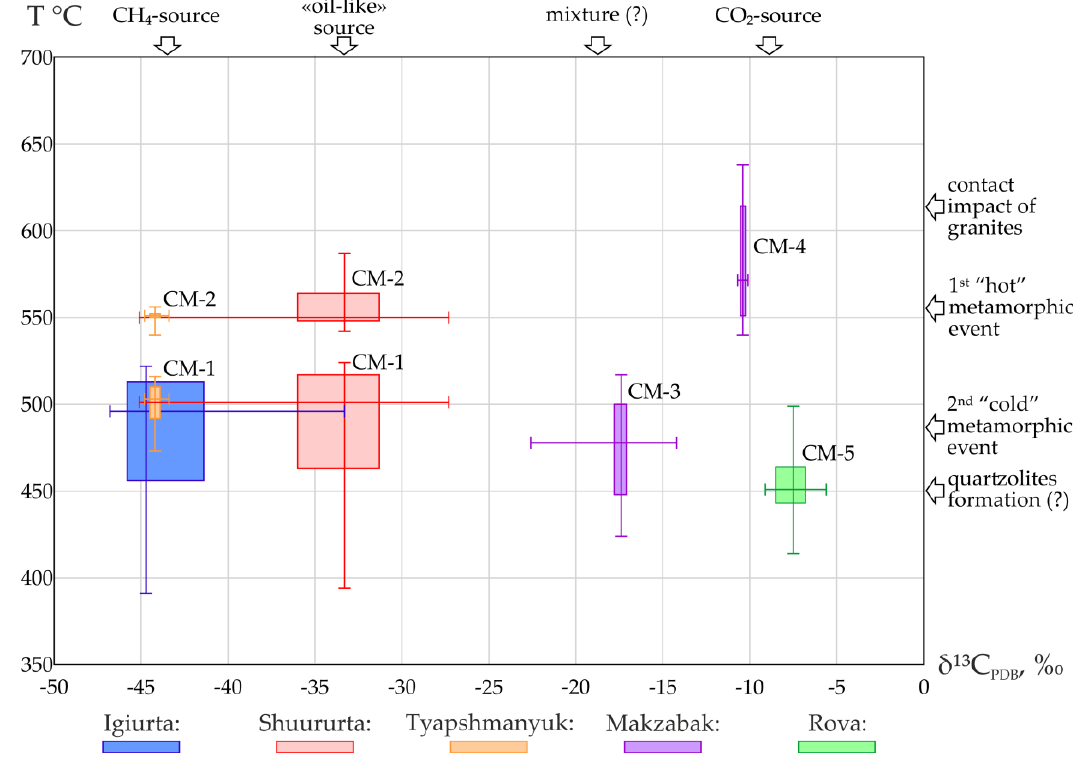
Figure 5. Variations in carbon isotope compositions (δ 13 C PDB ) and crystallization temperatures (T °C) of CM morphotypes (signed) from the rocks of the studied objects. Top marks the possible sources of carbon. To the right of the frame, the thermal mode of events during which CM crystallized is shown (the rationale for this data interpretation is discussed in Section 4). For the Shuururta and Tyapshmanyuk rocks, CM-1 and CM-2 were not amenable to separation, therefore the isotope characteristics of mixtures are displayed.